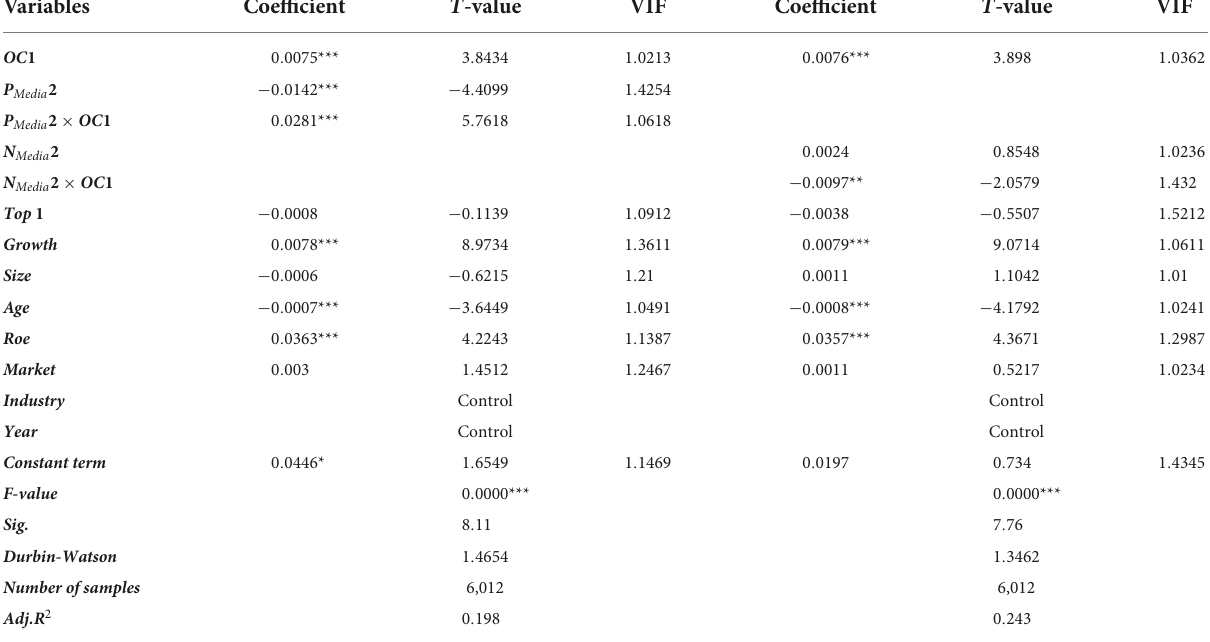
TABLE 10 Regression results of the moderating effect of positive and negative media reports.